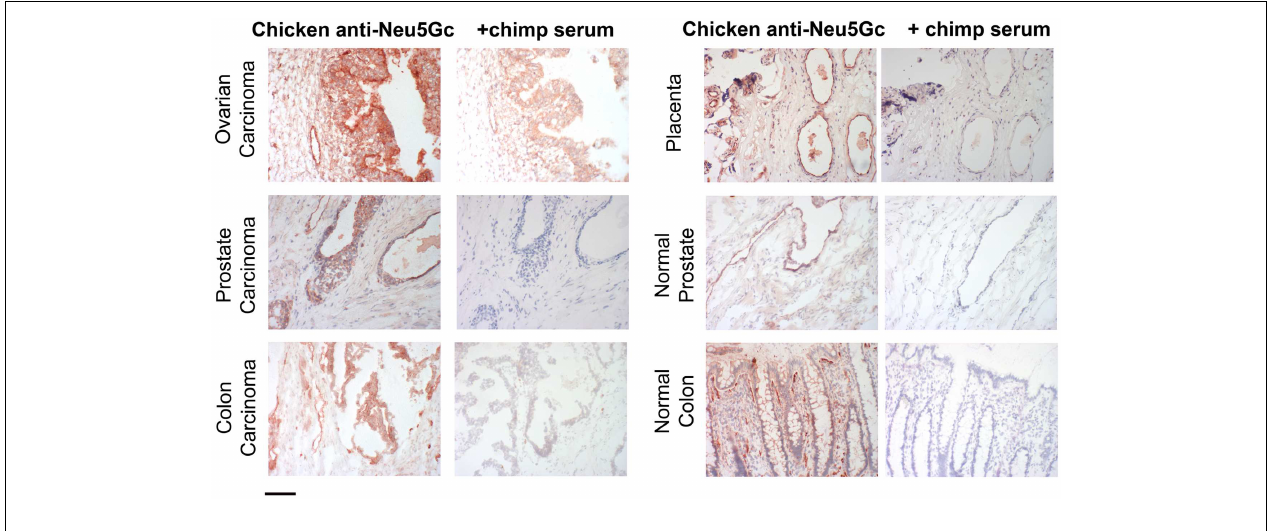
epithelial lining of the colon (Right panel). Endothelial cells of the normal placenta is used here as a positive control for Neu5Gc immunostaining. As a negative control, the binding is blocked competitively with Neu5Gc-containing chimpanzee serum. Magnification used was 200 × and scale bar is 100 µ